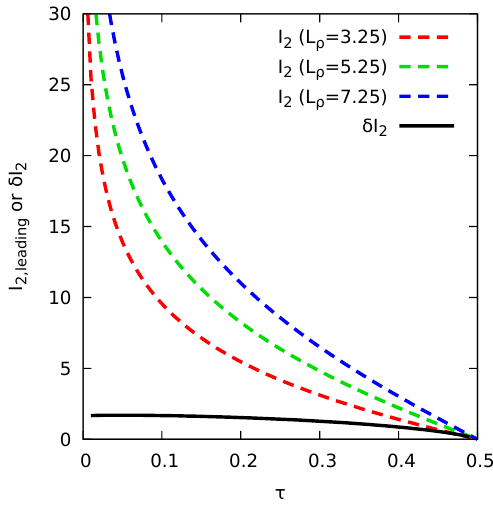
Figure 12 . Contribution of the subleading (cid:14)I 2 contribution, compared to the leading I 2 ; leading contribution for di(cid:11)erent values of L (cid:26) = log(1 =(cid:26)